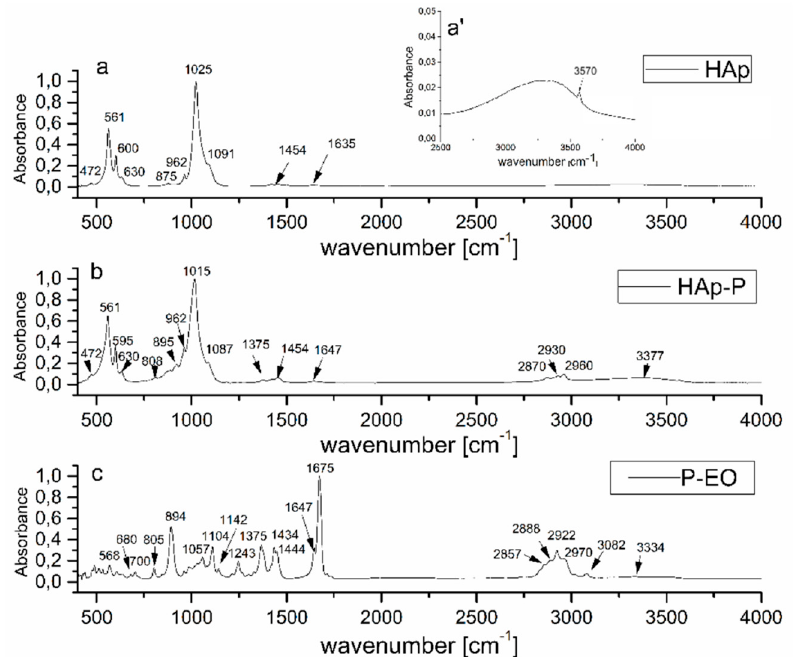
Figure 3. FTIR spectrum of ( a ) HAp, ( b ) HAp-P ( c ) and P-EO samples; FTIR spectra from of HAp sample from 2500 to 4000 cm − 1 ( a’ ).